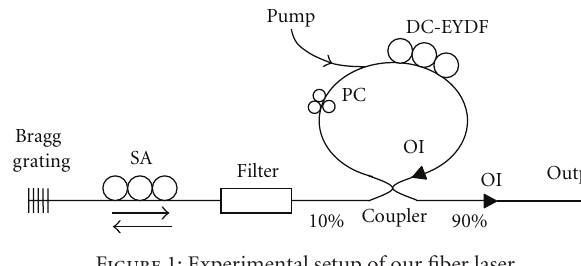
Figure 1: Experimental setup of our fiber laser.